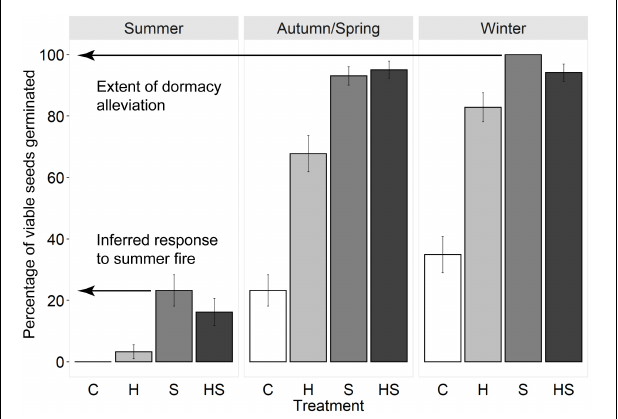
FIGURE 3 | Illustration of how seasonal changes in the state of dormancy and germination responses to fires in different seasons were inferred in the present study. In this example, seeds of Boronia floribunda were exhumed in early summer after 10 months’ burial and were subjected to factorial combinations of fire cues (C, control; H, heat pulse; S, smoke; HS, combined heat pulse plus smoke treatment) and incubated at one of three seasonal temperatures (top bar: summer, autumn/spring, winter). The minimum percentage of seeds in a non-dormant state after 10 months’ burial was inferred from the maximum germination response observed across all treatments (here, 100% after 6 weeks’ incubation). The inferred germination response to a summer fire in situ was taken as the maximum germination observed in response to any combination of fire cues at summer incubation temperatures (here, c. 24% after 6 weeks’